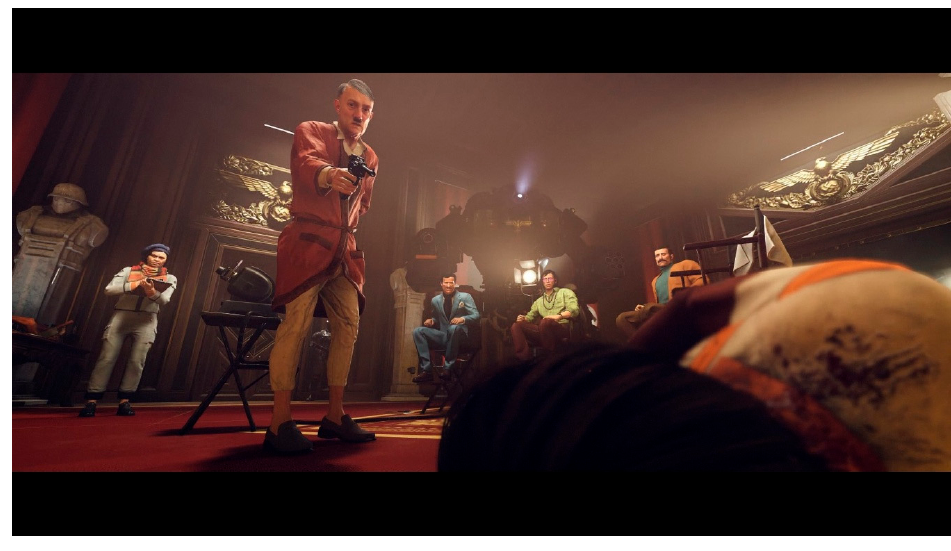
Figure 1. Hitler in his bathrobe killing an actor.